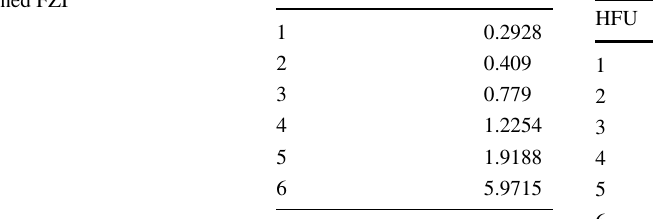
Table 2 Average porosity and permeability values for each HFU